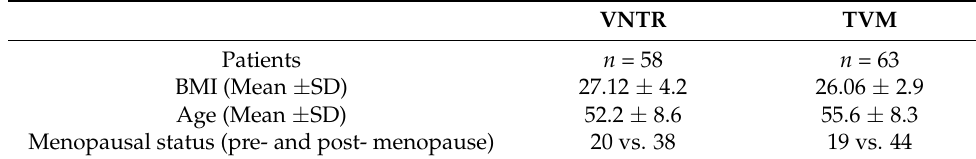
Table 1. Patient demographic and clinical